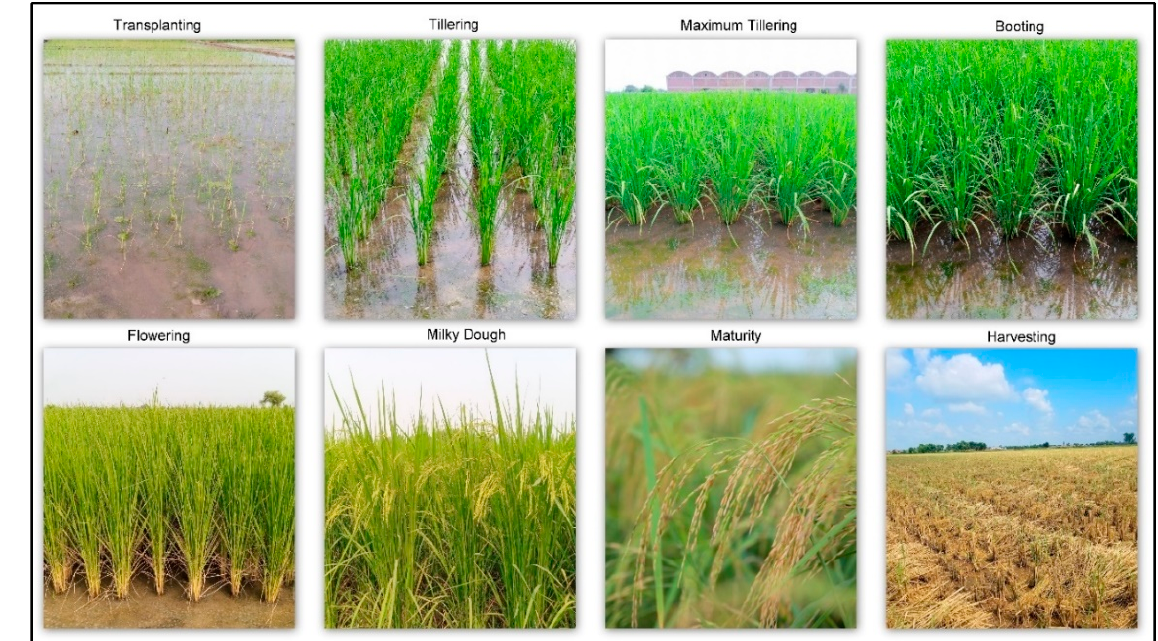
Figure 2. The pictorial view of different phenological or growth stages of rice in field conditions.